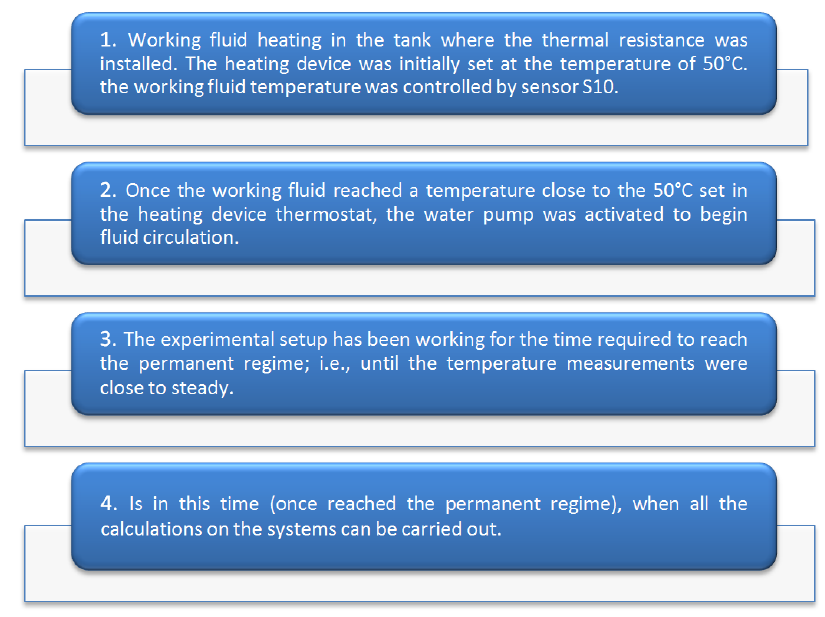
Figure 7. Description of the experimental methodology followed on the geothermal